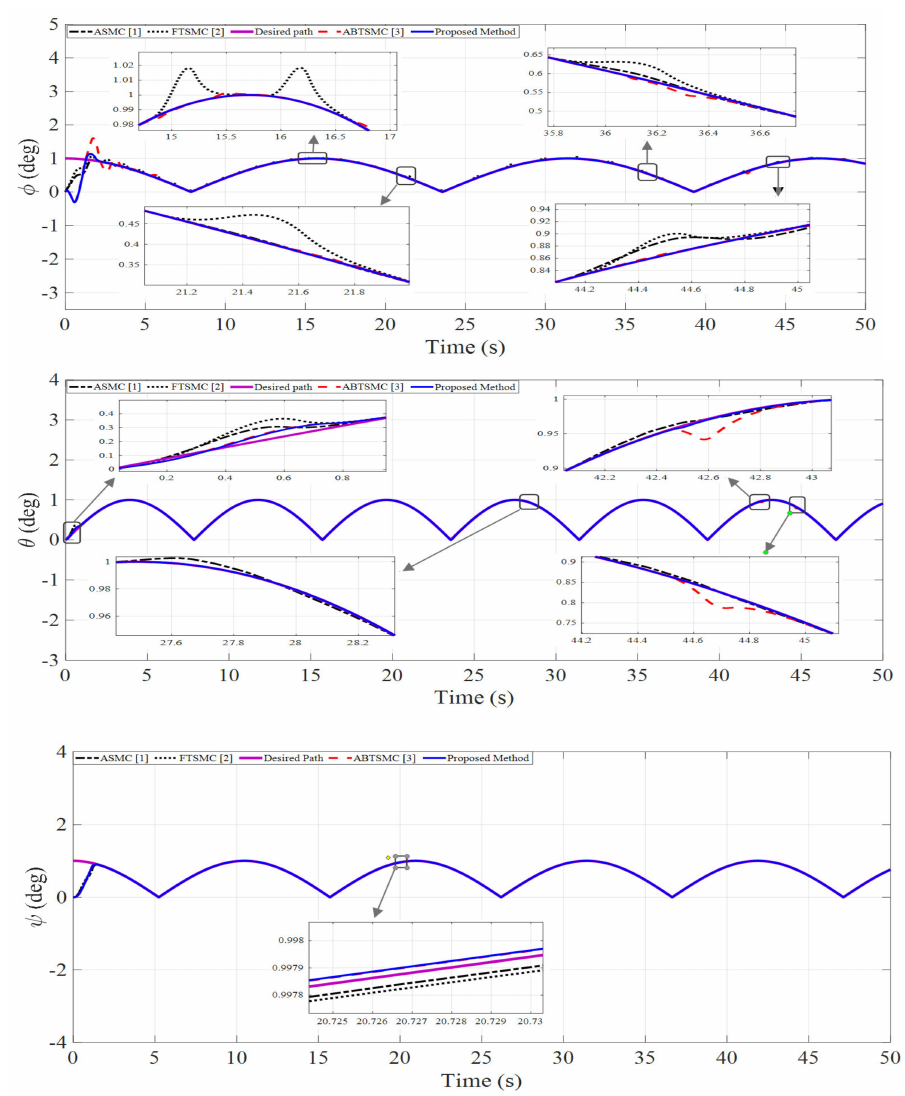
Figure 4. Quadrotor attitude under 40% sinusoidal fault in actuators 2 and